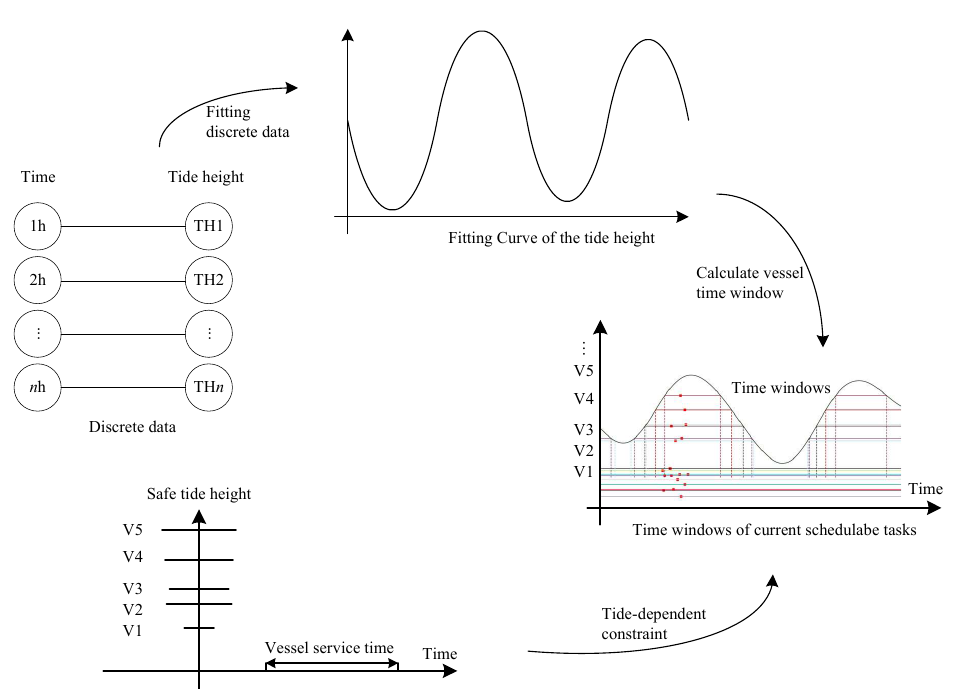
Figure 3. Process of determining the feasible tidal time window restricted by the tide height.